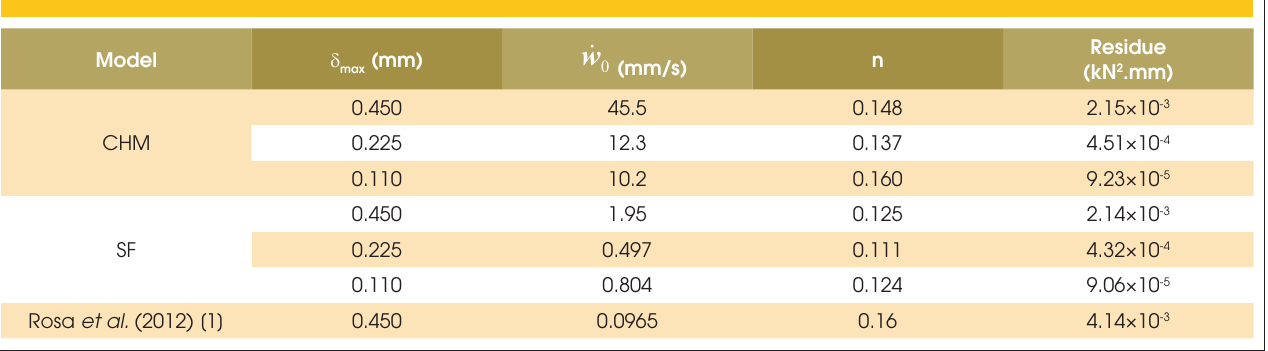
Table 2 – Results obtained by inverse analysis of the model [1] using the bilinear curve